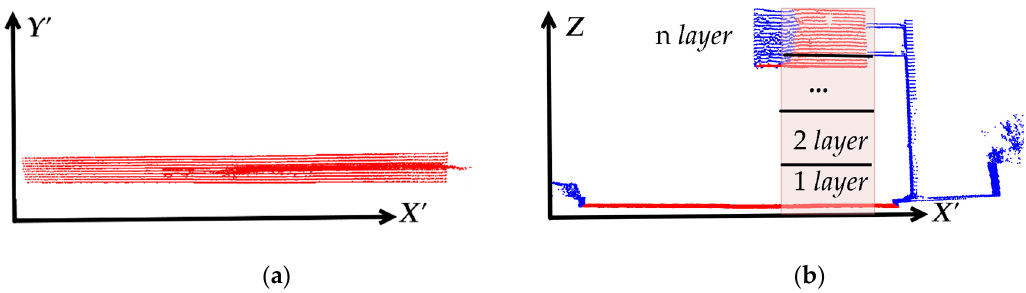
Figure 3. The point distributions of SHP i after coordinate transformation in ( a ) X’Y’ plane, ( b ) X’Z plane.